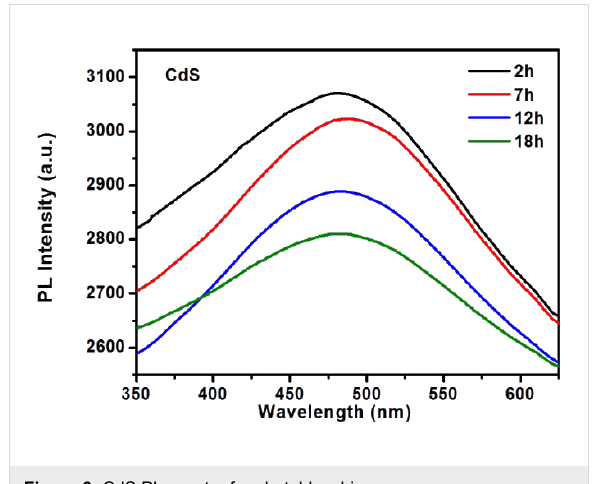
Figure 6: CdS PL spectra for